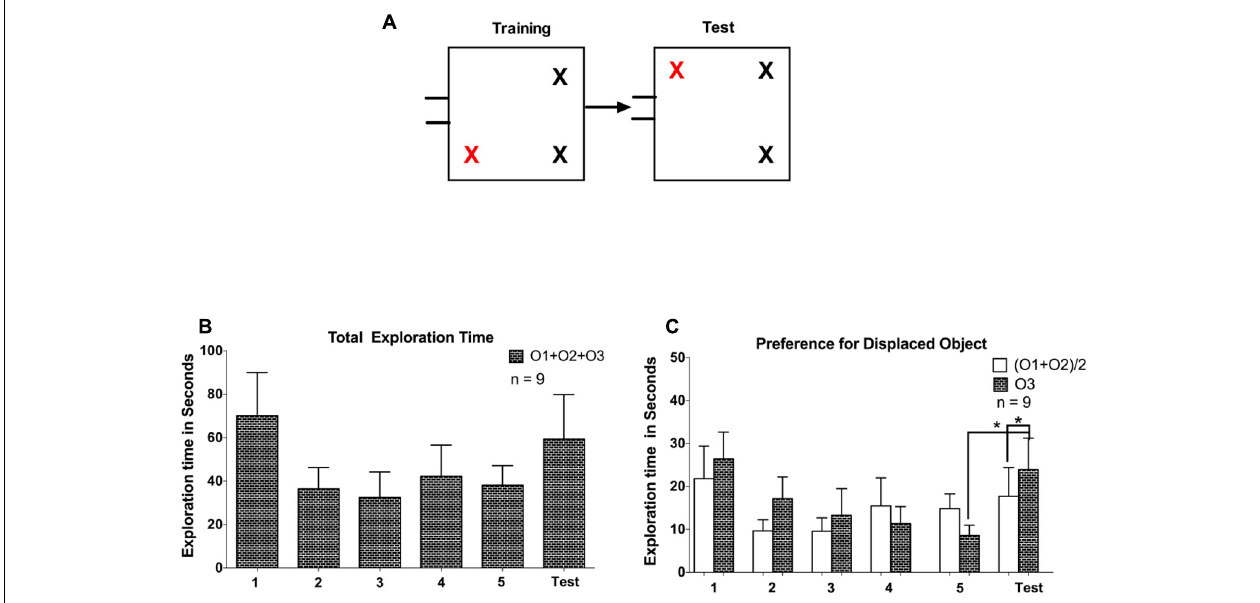
FIGURE 5 | (A) Representation of experiment phases in Experiment 3. (B) Total exploration time spent exploring all objects (O1 + O2 + O3). O3 represents the displaced object. (C) Comparison of exploratory activity for the displaced object O3 to the average of the non-displaced objects (O1 + O2)/2. Error bars denote the SEM (* P <